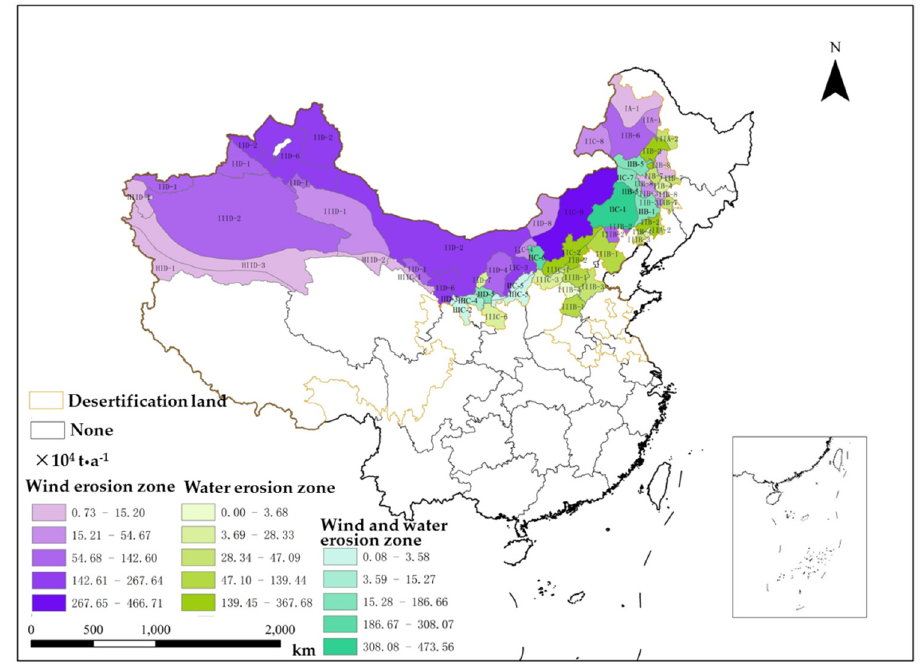
Figure 8. Dust retention by di ff erent ecological function zones.